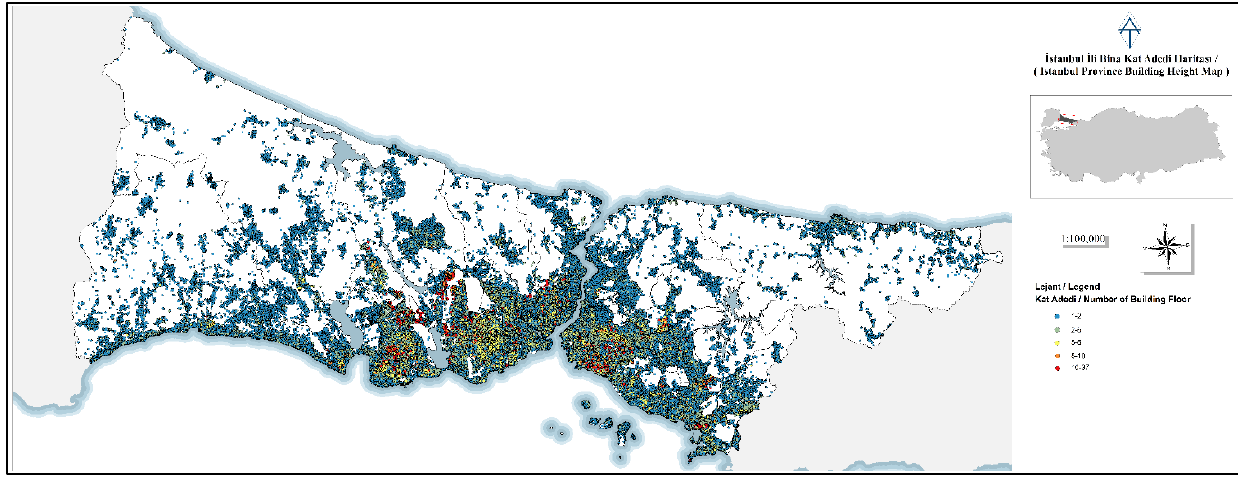
Figure 19. Istanbul Province Building Height Map.